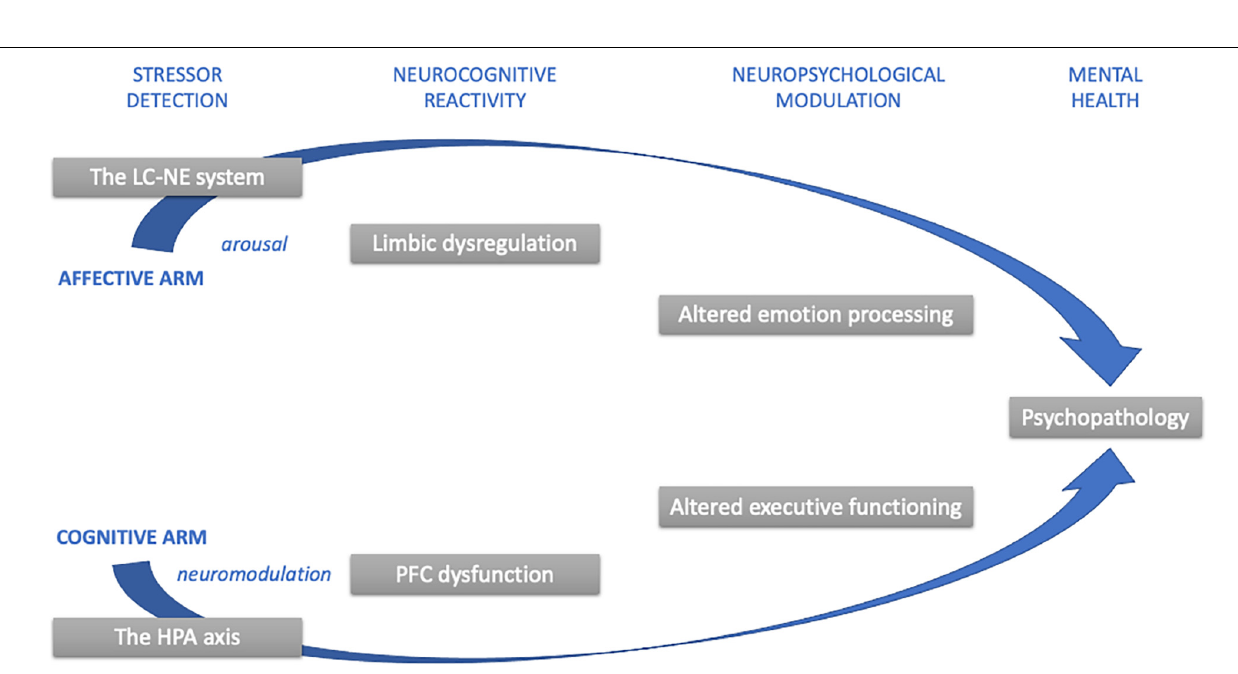
FIGURE 2 | Cognitive and emotional convergence associated with stress psychopathology. Note: This simplified diagram summarizes the pathways of cognitive and emotional convergence in stress that can lead to psychopathology. Abbreviations : HPA, hypothalamic–pituitary–adrenal; LC-NE, locus coeruleus.